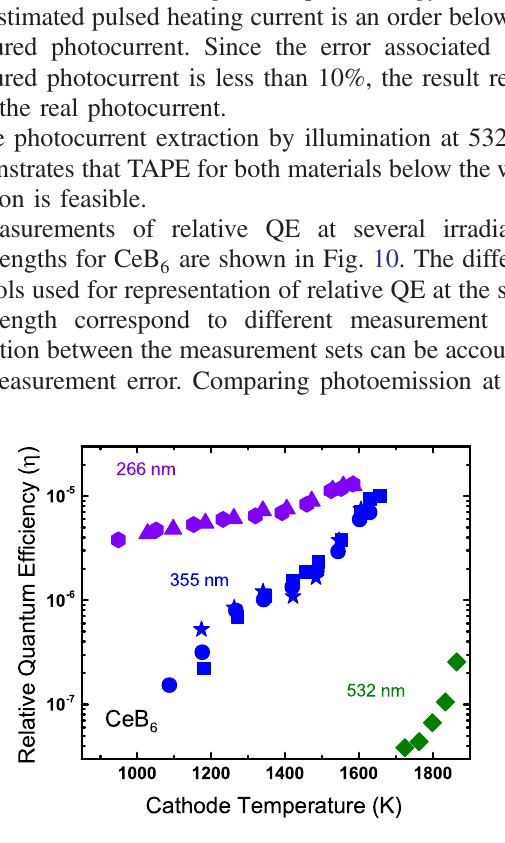
FIG. 10. Results of relative quantum efficiency measurement of CeB 6 cathode being irradiated at three different laser wave- lengths, 266, 355 and 532 nm, measured by heating up the